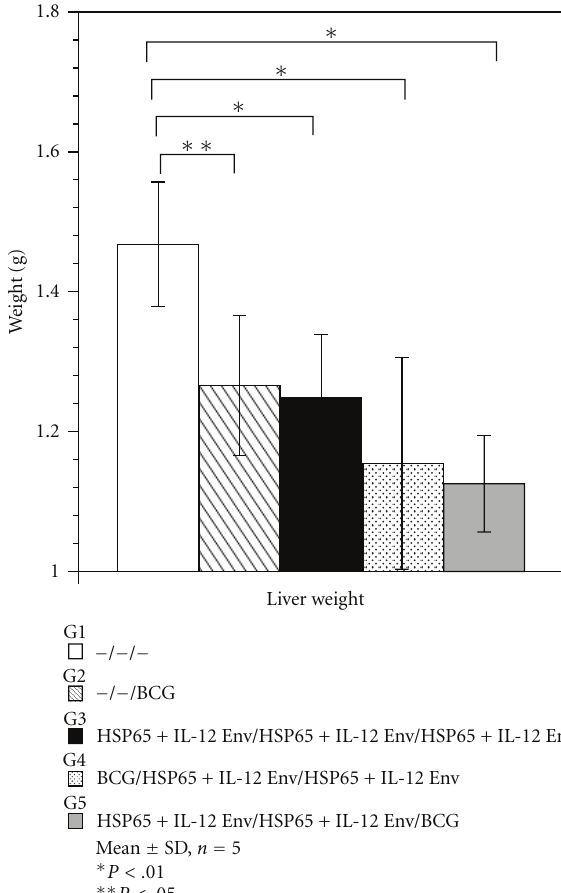
Figure 5: Tissue weight in mouse protection studies using the prime-boost method. Groups of mice vaccinated with HVJ-E DNA and/or BCG were challenged by intravenous injection with M. tuberculosis H37Rv. Five weeks after challenge, liver weight was measured. Results are expressed as the mean ± S.D. in grams (g). The statistical significance of di ff erences between individual groups in the weight was determined by Dunnett test ( n = 5), ∗ P < . 01; the statistical significance of di ff erences ( P ≤ . 01) of the G1 (naive) group compared to the G3 group (DNA/DNA/DNA), G4 group (BCG/DNA/DNA), or G5 group (DNA/DNA/BCG). ∗∗ P < . 05; that of di ff erences ( P < . 05) of the G1 group compared to the G2 group (BCG alone